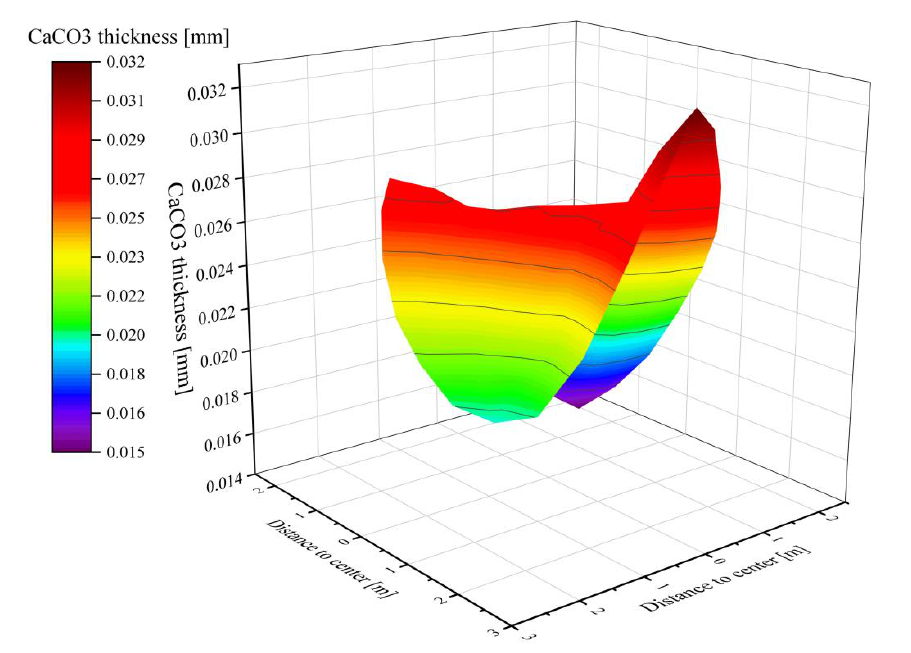
Figure 6. Thickness distribution of CaCO 3 at the outlet of calcination zone.